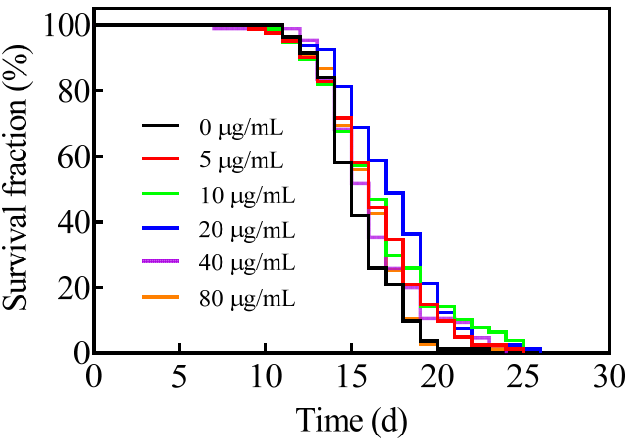
Figure 1. Effects of astaxanthin on the lifespan of C. elegans . Worms synchronized to adult stage were treated with different concentrations of astaxanthin (0, 5, 10, 20, 40, 80 μ g/mL). Table 1. Statistical analyses of the lifespan of C. elegans . Conc. ( µ